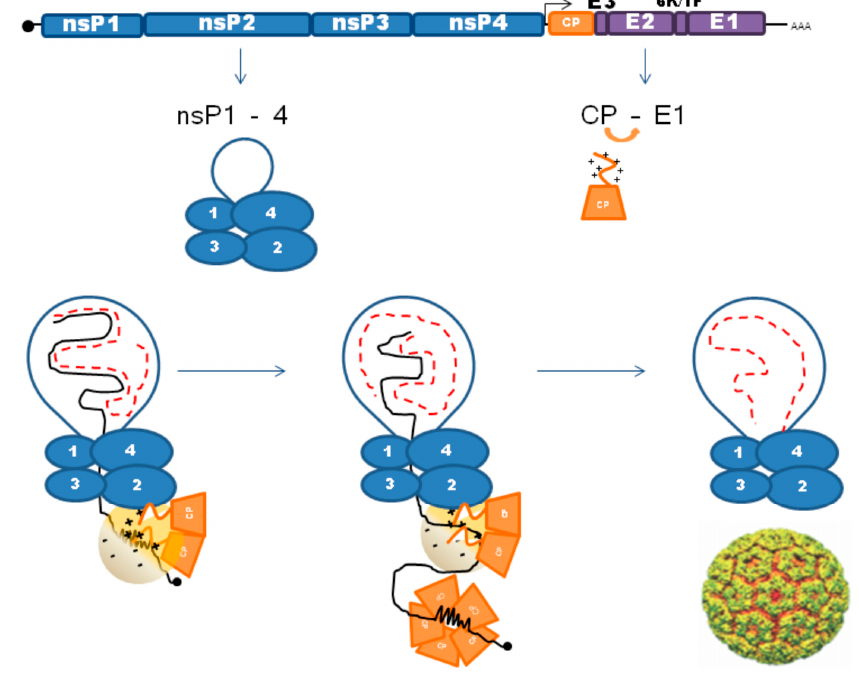
Figure 2. Model of NC assembly: Upon entry into the cell the alphavirus genome RNA is initially translated into the replication proteins nsP1-4. A spherule results when the replication complex of nsP1–4 (1–4) begins to synthesize RNA. RNA synthesis utilizes a negative strand (red dashed line)